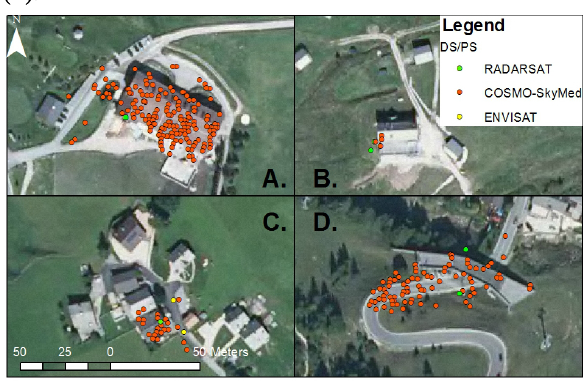
Figure 6: Locations with multiple sensor